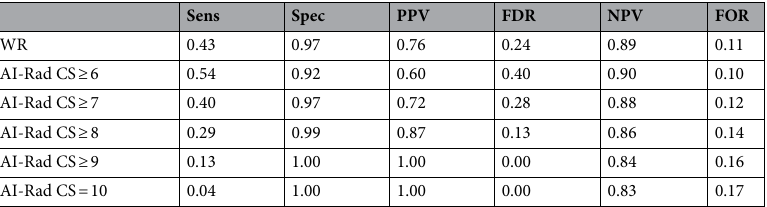
Table 5. Performance metrics of the radiologists (WR = written report) and the AI Rad Companion Chest X-ray (AI-Rad) for the detection of atelectasis. CS confidence score, PPV positive predictive value, NPV negative predictive value, FDR false discovery rate, FOR false omission